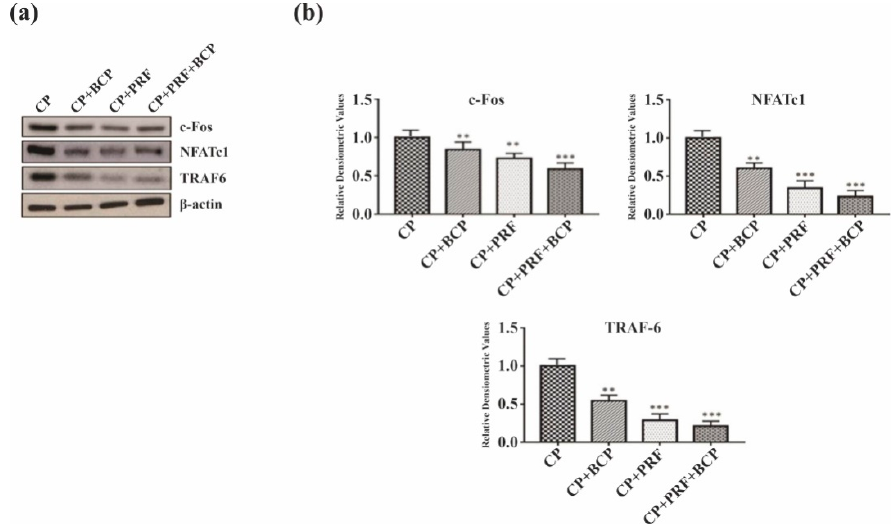
Figure 4. PRF/BCP inhibits osteoclastogenic transcription factors. Results are expressed as the mean ± SD. Western blot analysis of osteoclast pathway molecules ( c-Fos , NFATc1 and TRAF 6) was blotted and normalized with β -actin. ( a ) Representative blot image. ( b ) Relative densitometric analysis in histograms. Results are expressed as mean ± SD. Comparisons were made among CP and BCP, CP and PRF, and CP and PRF/BCP combination. (** p < 0.01; *** p < 0.001).